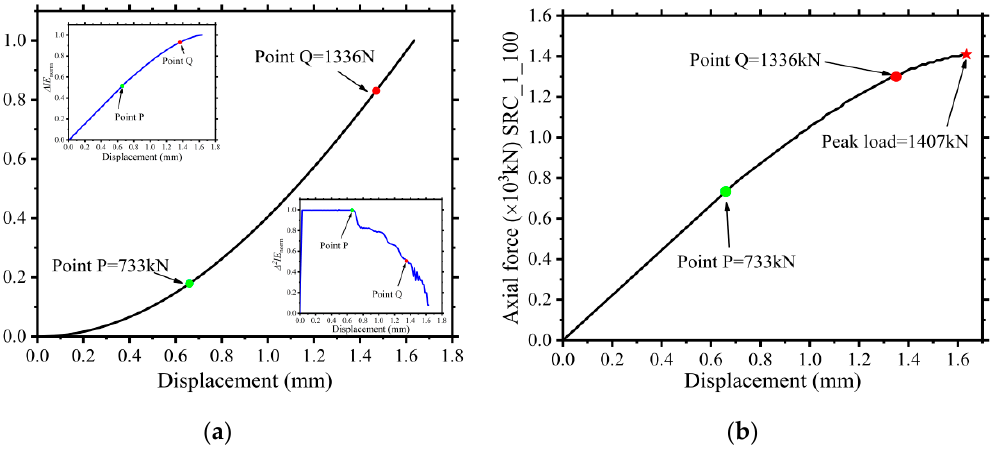
Figure 6. IE norm -displacement figure and axial force-Displacement figure: ( a ) IE norm -Displacement of SRC_1_100; ( b ) Axial force-Displacement SRC_1_100.